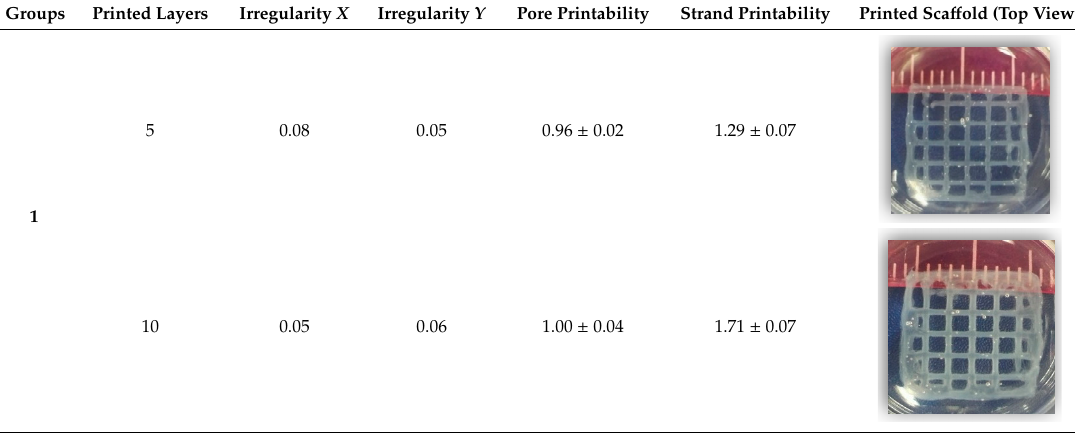
Table 3. The 3D printability results for the bioplotted scaffolds made from Groups 1 to 4. shows that biomaterials are not printable or a large deviation is